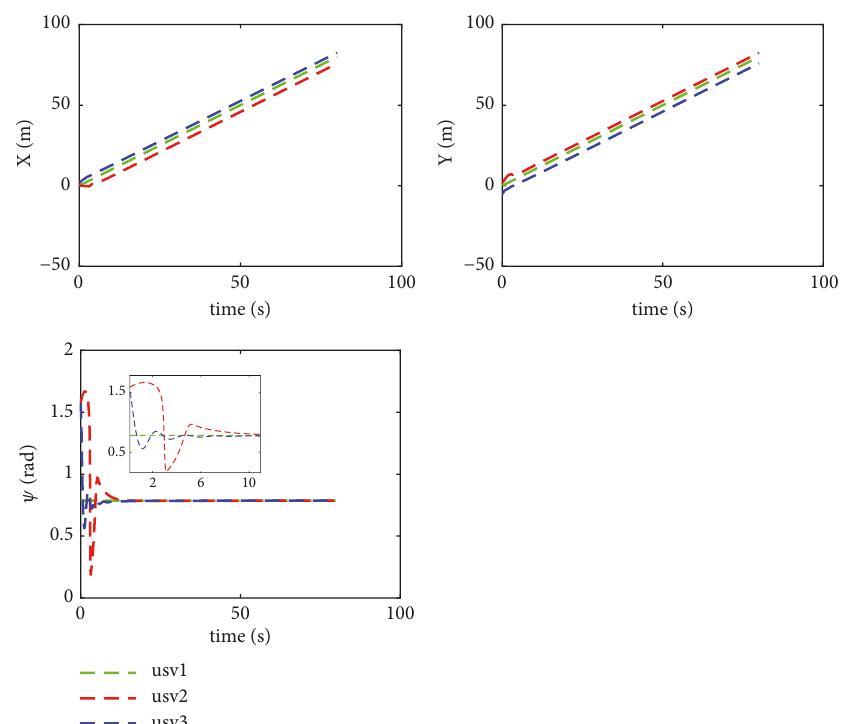
Figure 3: The position and attitude of the three USV.